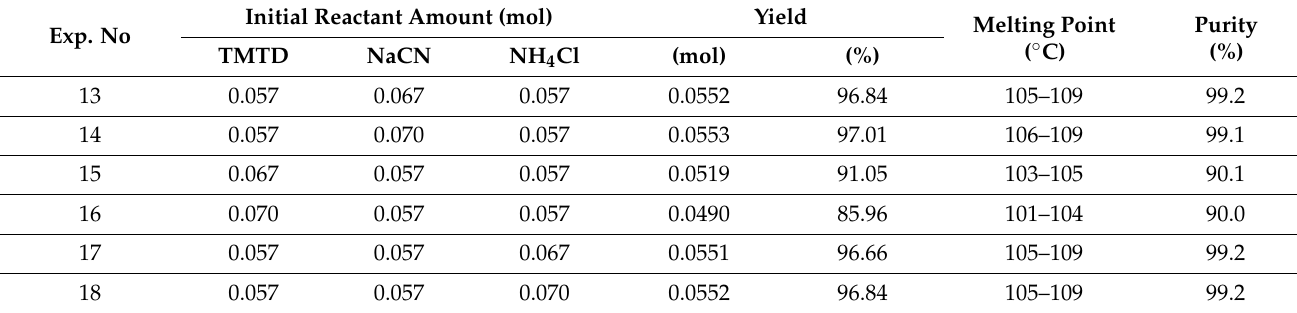
Table 3. The yield of TMTS as a function of the amounts of reactants (a) .